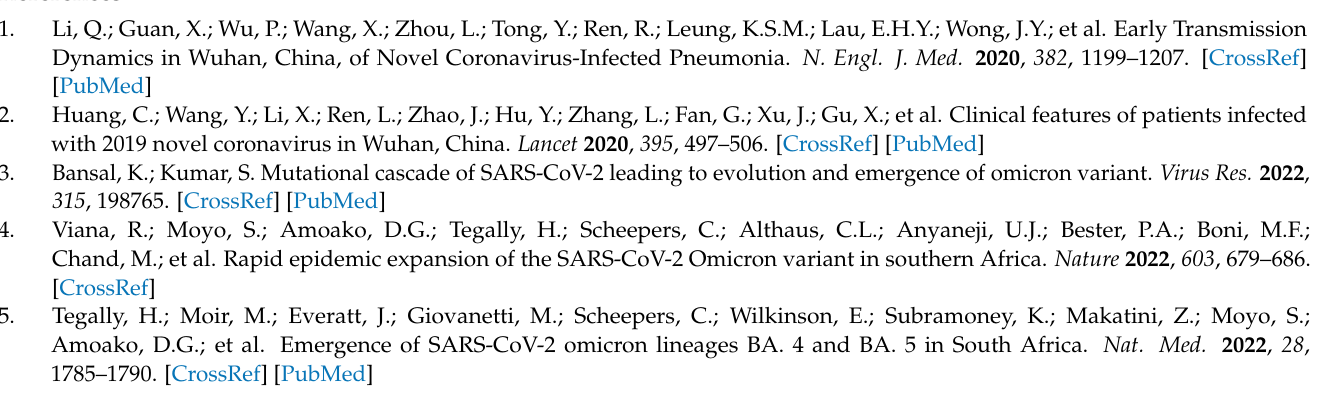
Table S2: Genome information of representative